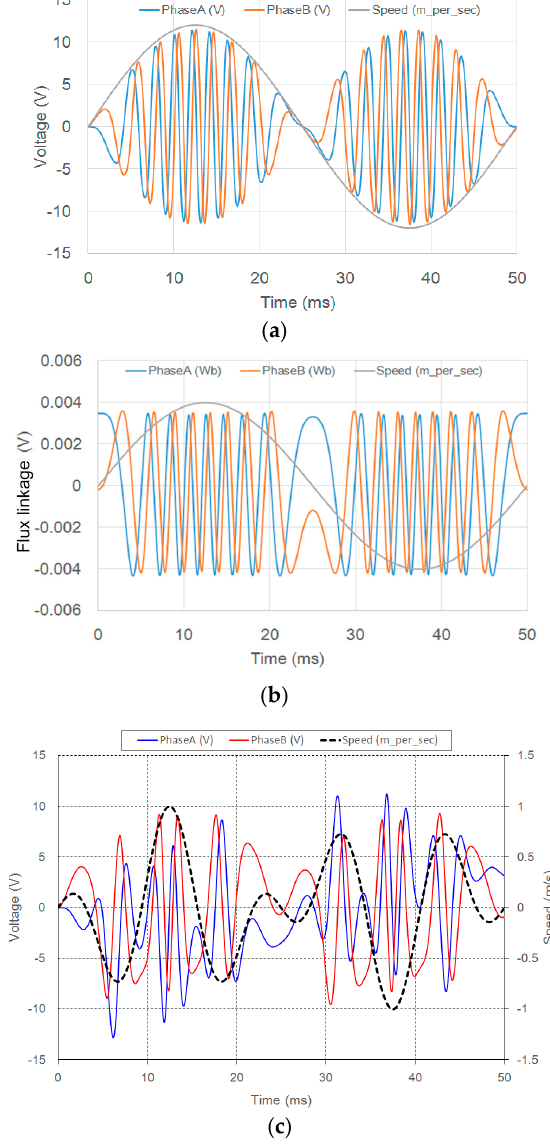
Figure 15. ( a ) Open circuit voltage of each phase and ( b ) corresponding flux linkage under the sinusoid speed with amplitude 1 m/s; ( c ) voltage output under a variable speed.